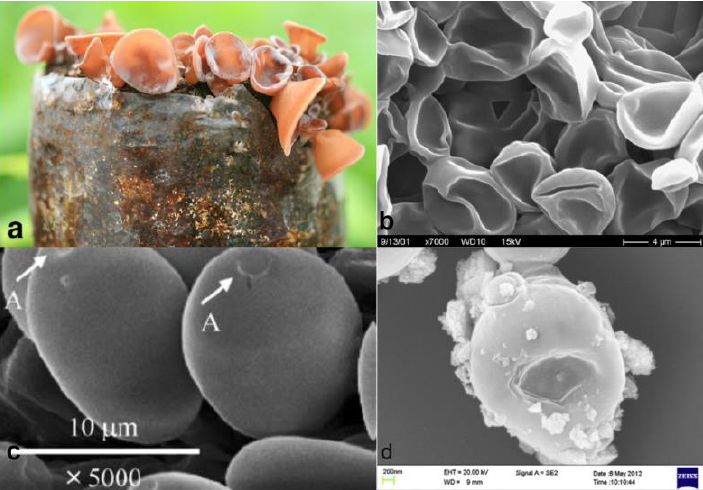
Figure 3. Photographs of ( a , b ) the bulk and ( c , d ) cellular structures of ( a , c ) mushrooms and ( b , d ) yeasts, respectively [the species shown in the images are ( a ) Auricularia thailandica, ( b , d ) Saccharomyces cerevisiae and ( c ) Psilocybe cubensis. The arrow in C indicated the germ spores. ( a ) Reproduced from [79], with permission from Springer Nature; 2017. And ( b ) from [80], ( c ) from [81], ( d ) from [82], with permission from Elsevier 2003, 2003 and 2015.